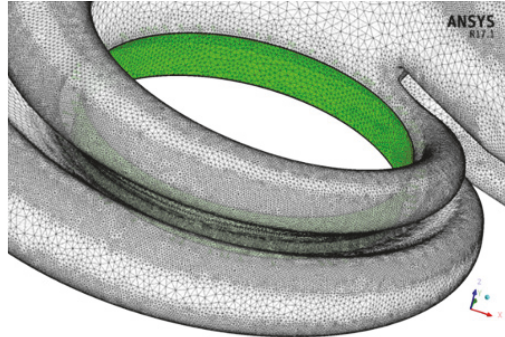
Figure 3: Unstructured grid detail on the two volute branches (shroud side the upper and hub side the lower). In green is highlighted the volute outlet section, which feeds turbine